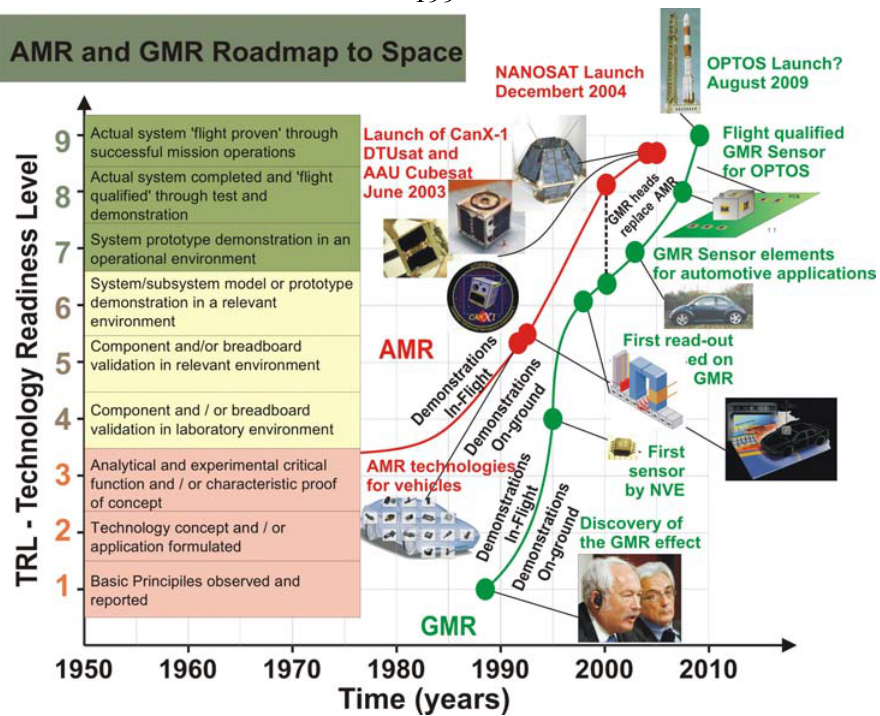
Figure 2. The graph represents the roadmap for space of AMR and GMR technologies. In the horizontal axis it is represented the time and in the vertical axis the Test Readiness Level. Below the curves some of the on-ground demonstrations are shown; above the curves the in-flight demonstrations are